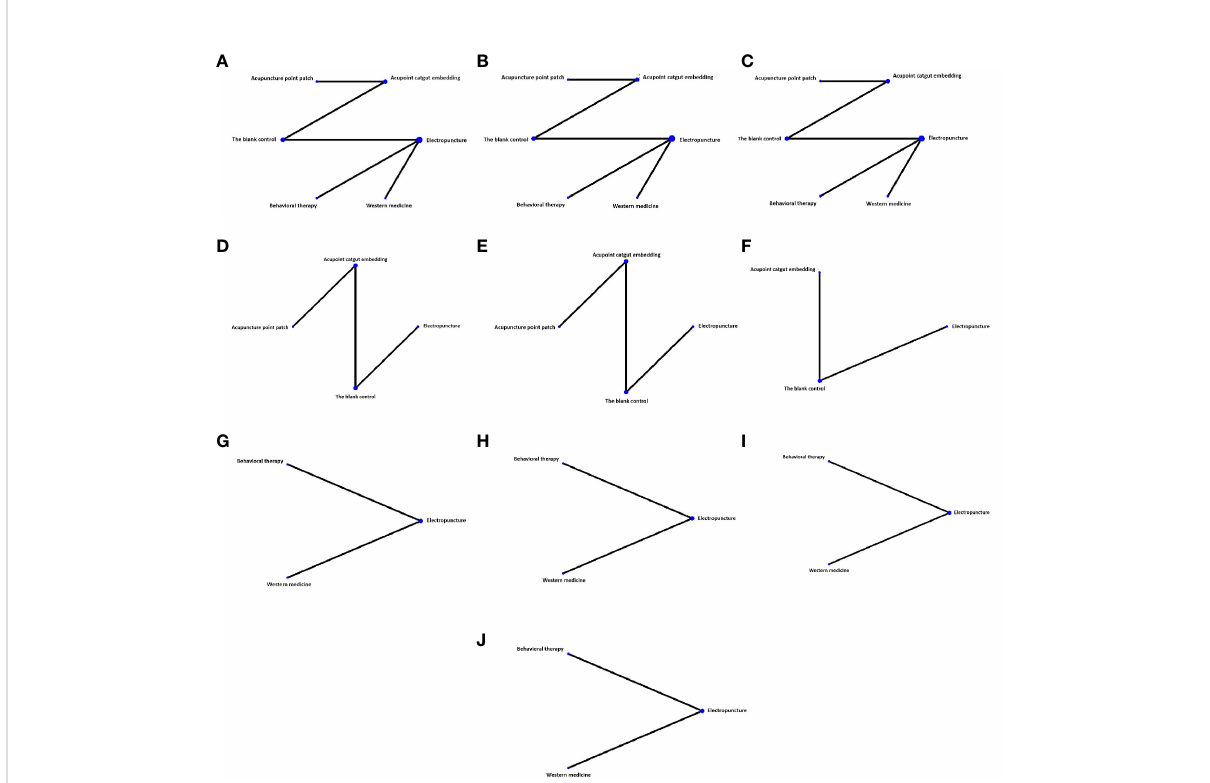
FIGURE 2 Network diagram of different indexes treated by different types of intervention. The fi gure shows that each intervention is indicated with a single blue dot. The size of the dot represents the cumulative total sample size of the intervention. The line segment between the dots represents the studies that have a direct comparison between the two interventions. (A) Fasting blood glucose, (B) fasting serum insulin, (C) homeostasis model assessment — insulin resistance, (D) BMI, (E) waistline, (F) waist – hip ratio, (G) triglyceride, (H) total cholesterol, (I) high-density lipoprotein, and (J) low-density